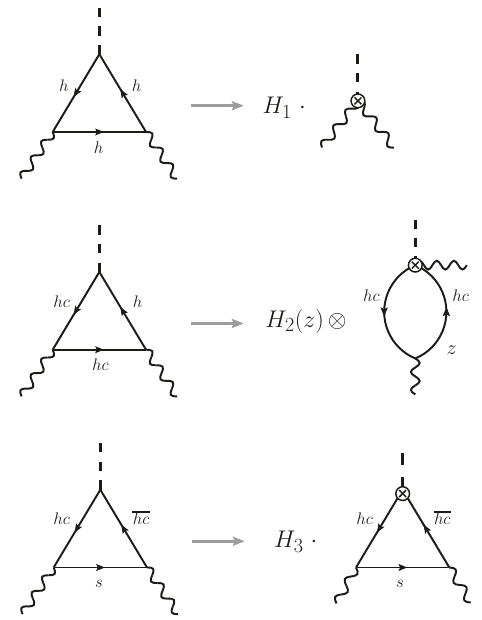
Figure 3 . Leading regions of loop momenta contributing to the decay amplitude. The convolution symbol (cid:10) in the second term means an integral over z